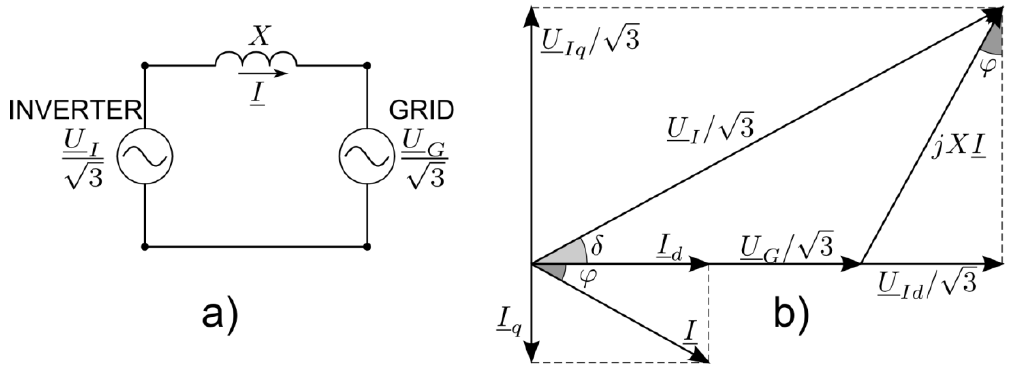
Figure 14. ( a ) Inverter equivalent circuit; ( b ) Phasor diagram related to voltage and current